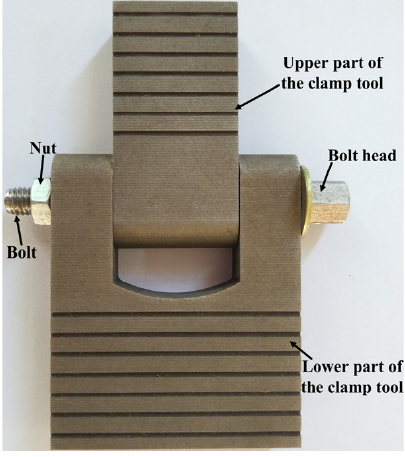
Figure 13. Bolt and clamp tool.